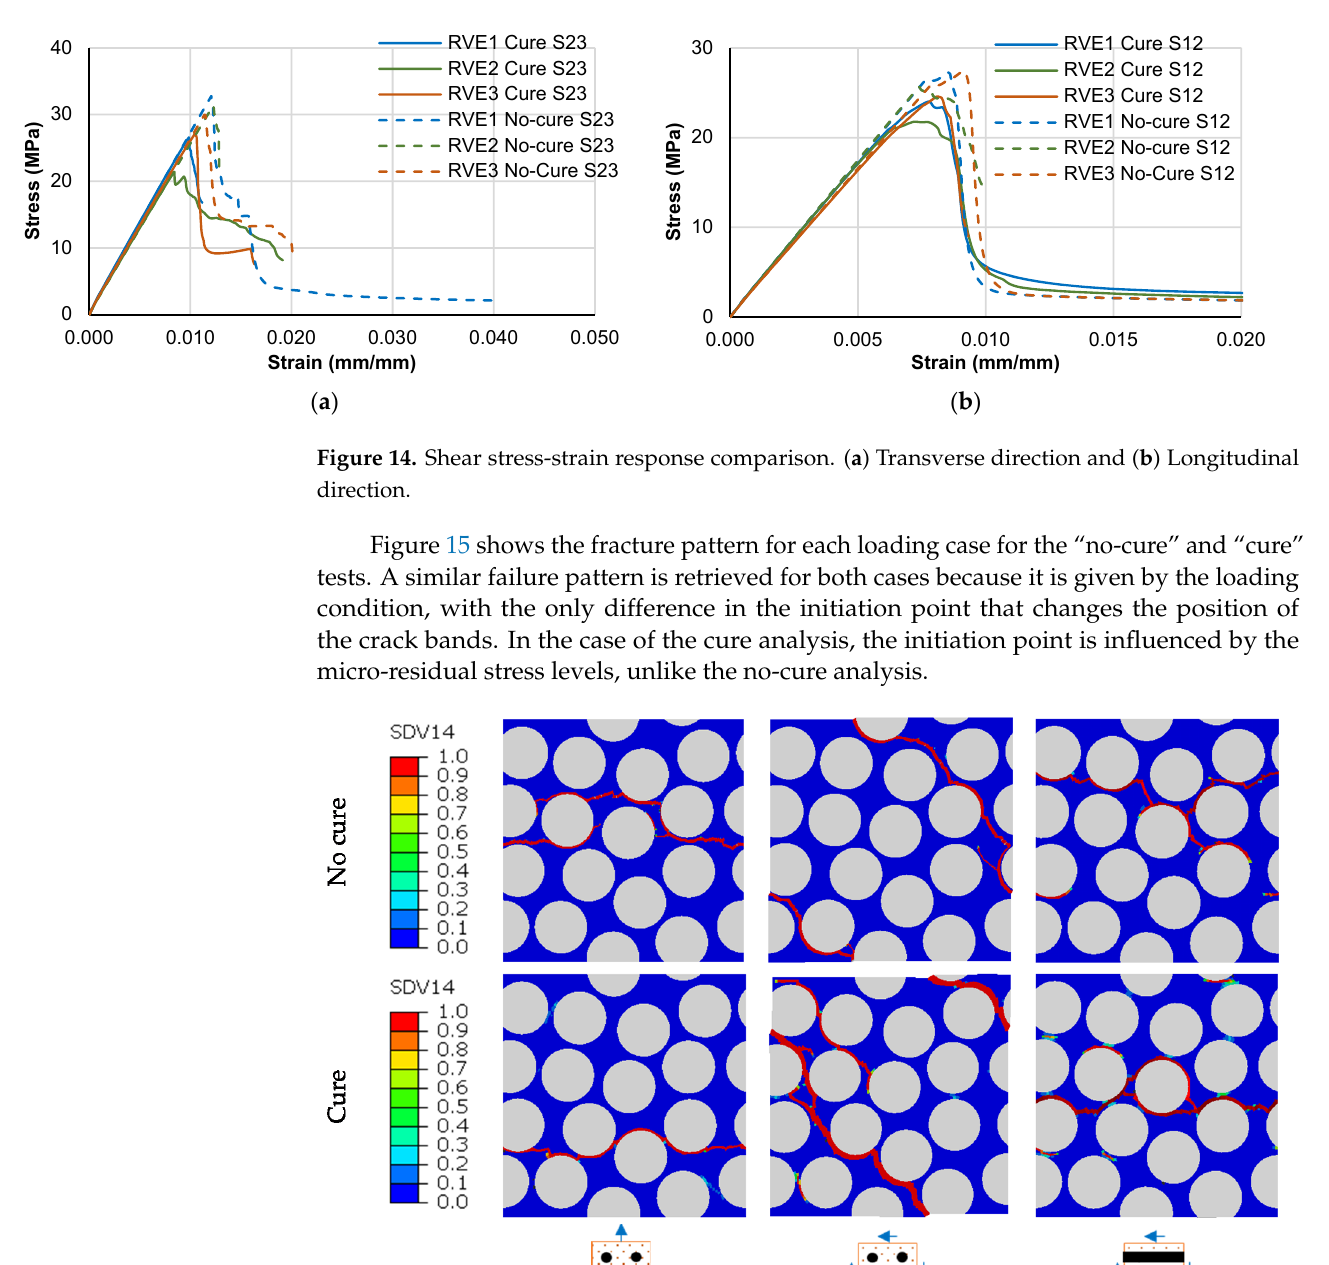
Figure 13. Transverse tensile stress-strain response comparison.